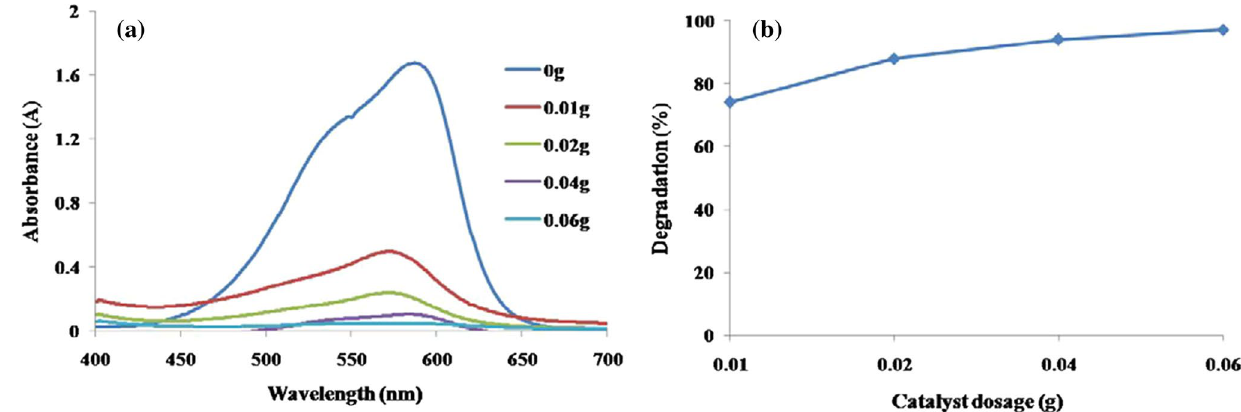
Fig. 9 a UV–Vis spectra of MV before and after UV light irradiation time in the presence of different amounts of Co/cross-linked chitosan, b %degradation of MV dye photodegraded by different amounts of Co/cross-linked chitosan Fig. 10 %Degradation of MV at various initial dye concentration photodegraded by Co/cross- linked chitosan